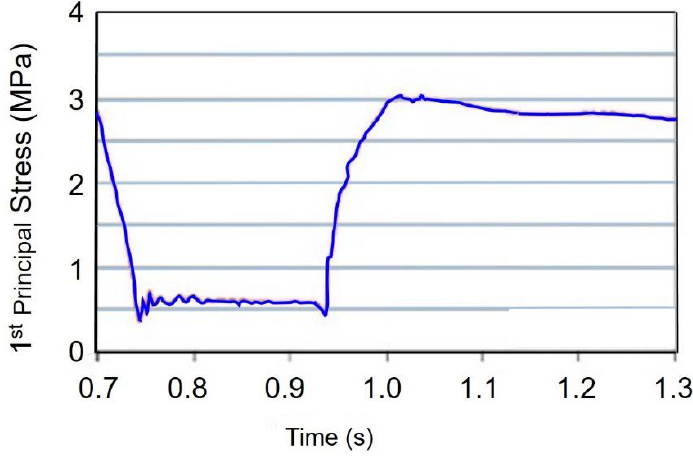
Figure 8. Plot of 1st principal stress vs. time at commissure point [23].